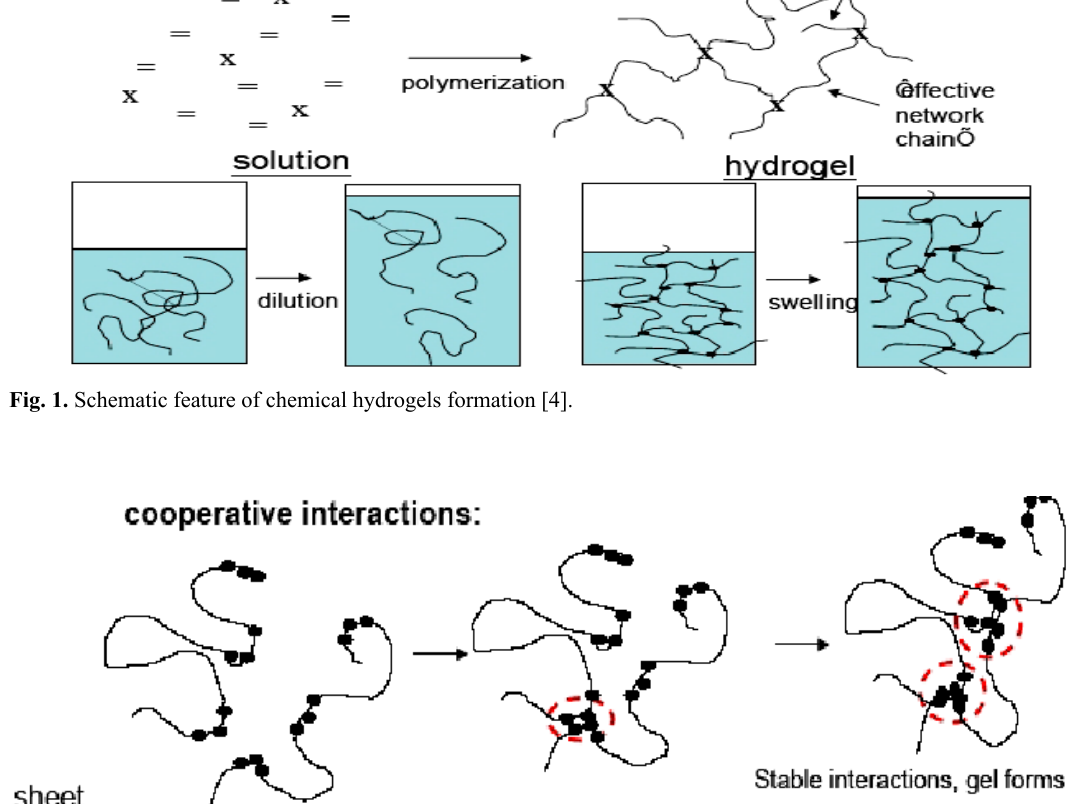
Fig. 2 . Shematic view of the physical formation of hydrogels [6].